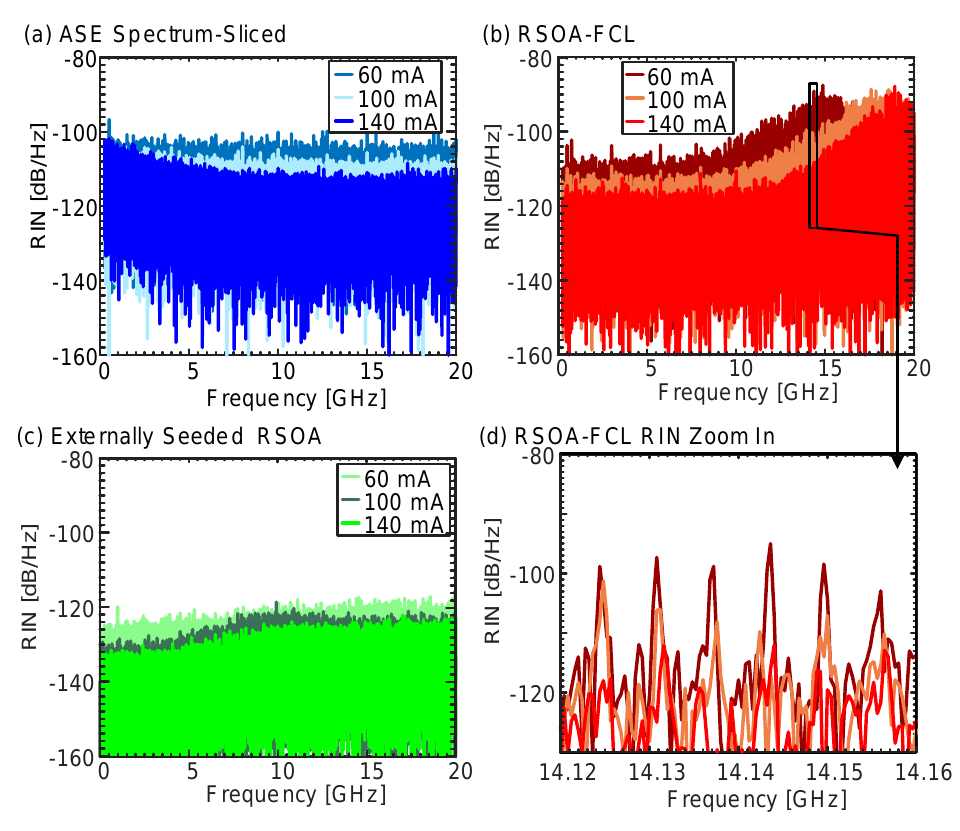
Figure 10. Measured RIN at 60, 100 and 140 mA RSOA bias currents: ( a ) For the RSOA ASE spectrum-sliced; ( b ) self-seeded RSOA-FCL; and ( c ) externally seeded RSOA colorless transmitters. For all cases, the RIN increases for lower bias current. The externally seeded RSOA shows the lower RIN followed by the RSOA-FCL; ( d ) shows the zoomed in section of ( b ) where the RIN shows peaks corresponding to the longitudinal modes of a 15 m SMF cavity